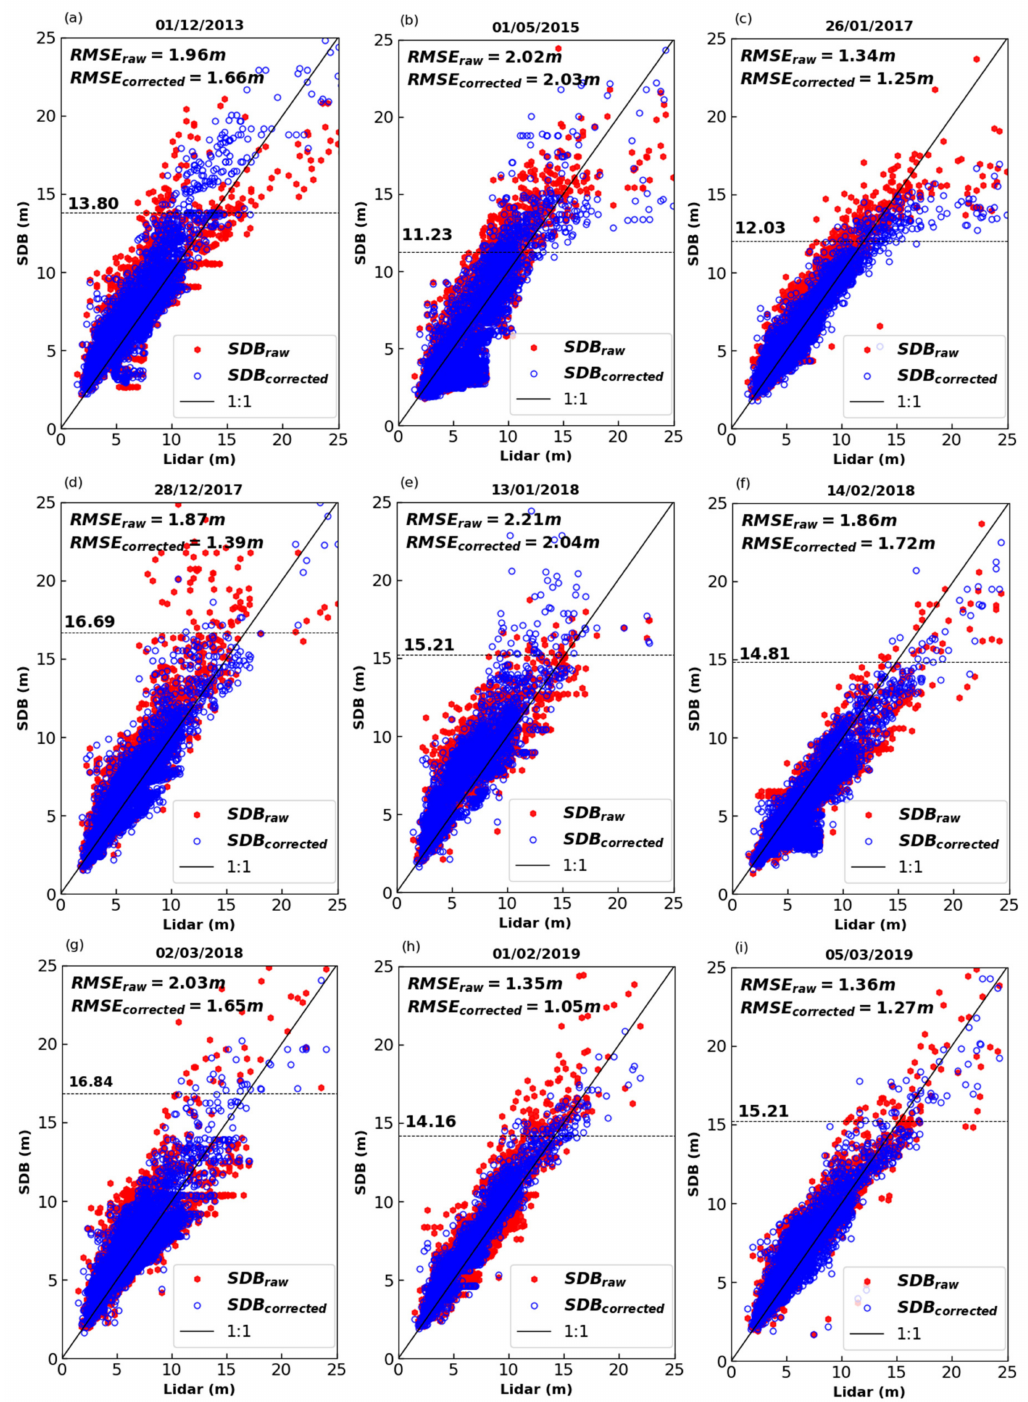
Figure 4. ( a – i ) Scatterplots of satellite-derived bathymetry estimates versus LiDAR measurements. Red points show water depth estimates obtained from original ACOLITE outputs; blue points show estimates obtained after applying the correction factor. The 1:1 line is shown in black. The dotted horizontal lines and values above them denote threshold values beyond which the water column is deemed optically deep. Threshold value was calculated using Mean − 2 Standard deviation of a 33 × 33 window pixel selected over an optically deep homogeneous area in an